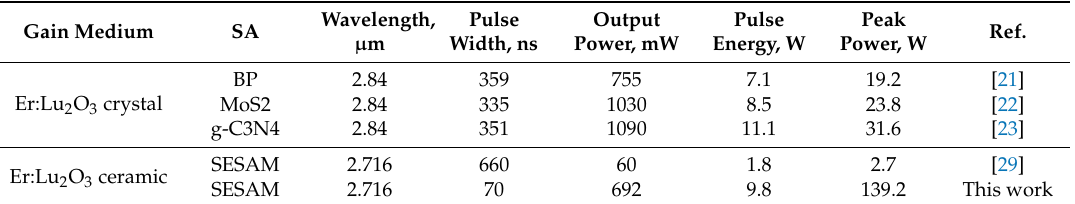
Figure 5. Temporal profiles of the Q-switched pulse trains at different time scales. Table 1. Comparison of output characteristics of the Er:Lu 2 O 3 lasers operating around 3 µ m passively Q-switched by various SAs reported so